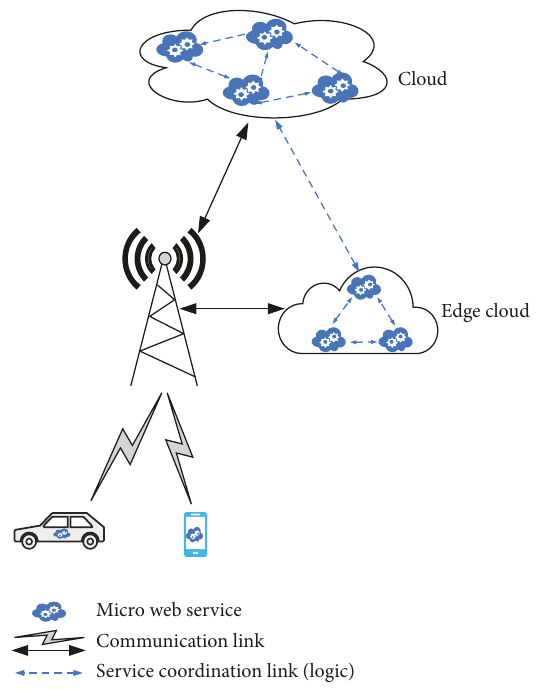
Figure 2: MEC and SOA